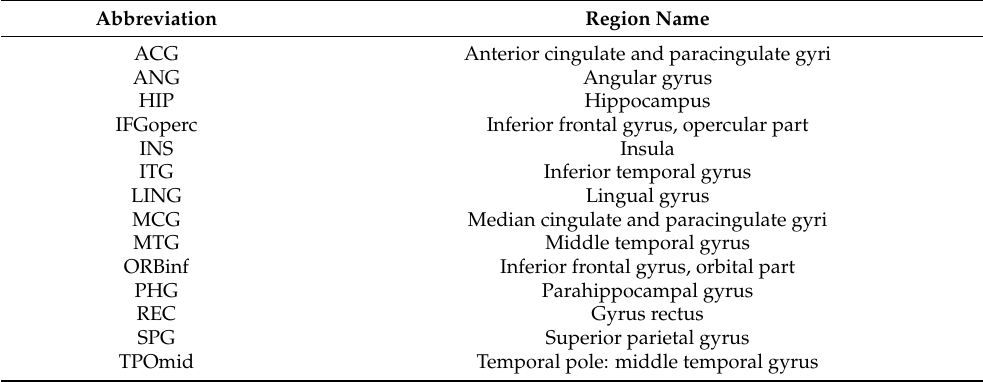
Table 1. Abbreviations for brain